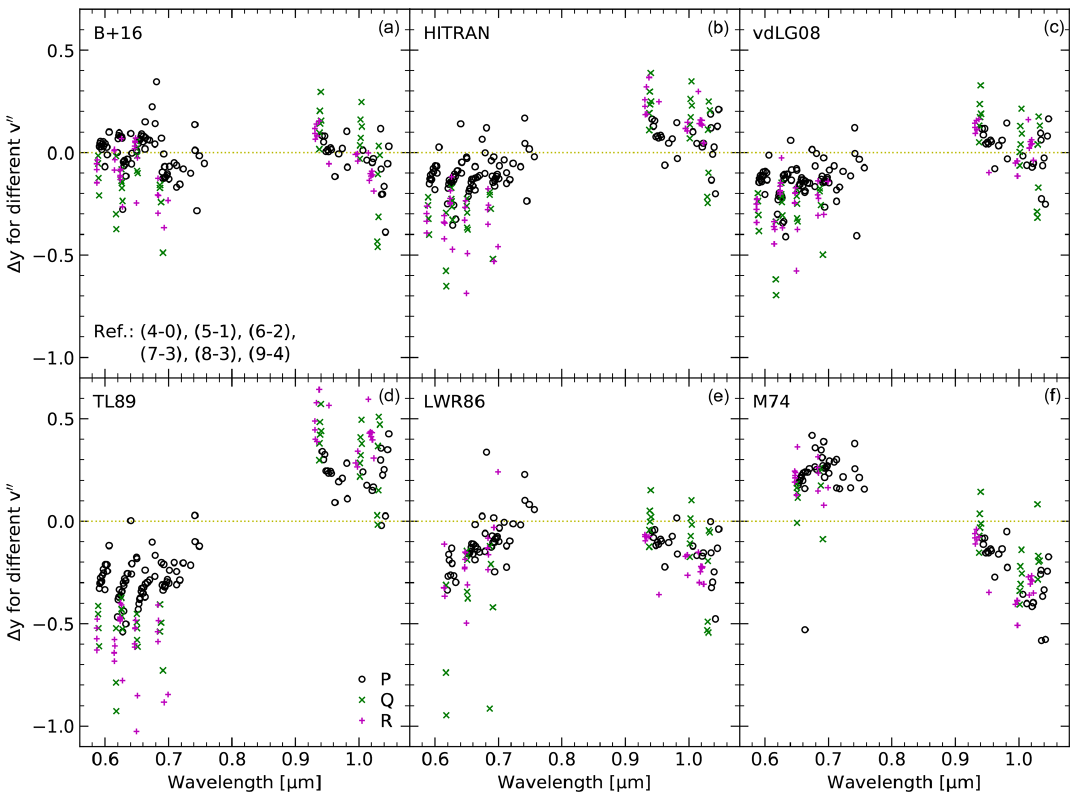
Figure 8. Difference in logarithmic OH level populations (cid:49)y by the change of the lower vibrational level v (cid:48)(cid:48) of the measured transitions as a function of the mean wavelength of the (cid:51) doublet in micrometres for six sets of Einstein- A coefficients. For the reference bands OH(4-0), OH(5-1), OH(6-2), OH(7-3), OH(8-3), and OH(9-4), the resulting (cid:49)y are zero and are therefore not shown. OH(3-0) is also neglected since it is the only band with v (cid:48) = 3. Finally, additional bands at short wavelengths are missing in the case of the limited sets of Langhoff et al. (1986) and Mies (1974). For more details, see the legend and Fig.